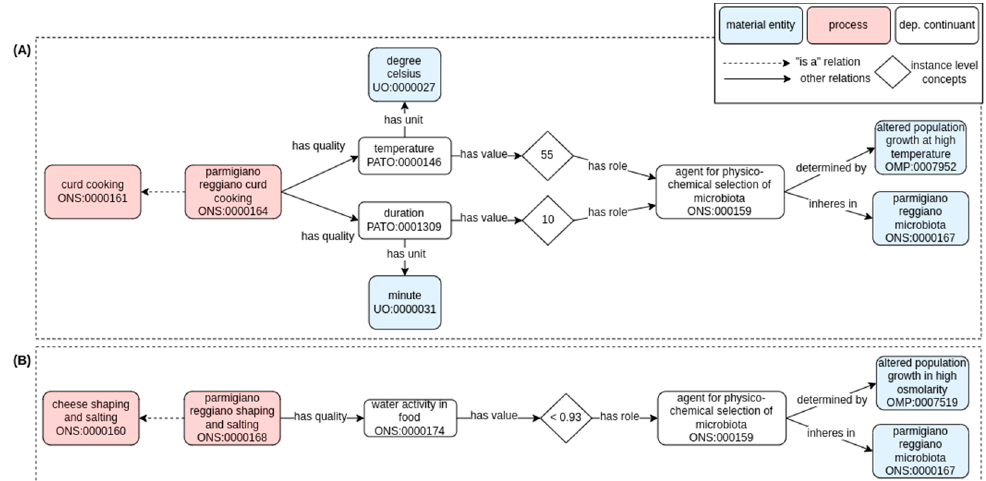
Figure 7. Ontological model depicting some technological steps in dairy food fermentation by imposing selective pressure on the microbial community based on temperature ( A ) or water activity ( B ); fundamental for determining the microbiota composition in the final food. Solid arrows represent semantic relations in RO (annotated with their label), while dashed arrows represent hierarchical relationships (i.e., “is a” relation). Pink and blue rectangles refer to process or material entity, respectively. The label and the term ID (formatted as an ontology prefix followed by a number) are reported for each class. Classes are generally conceptualized to the universal level (i.e., the definition and concepts apply to any possible class instance). When suitable, instance-level concepts (indicated with white rhombus) are used to indicate a particular instance of the universal concept.